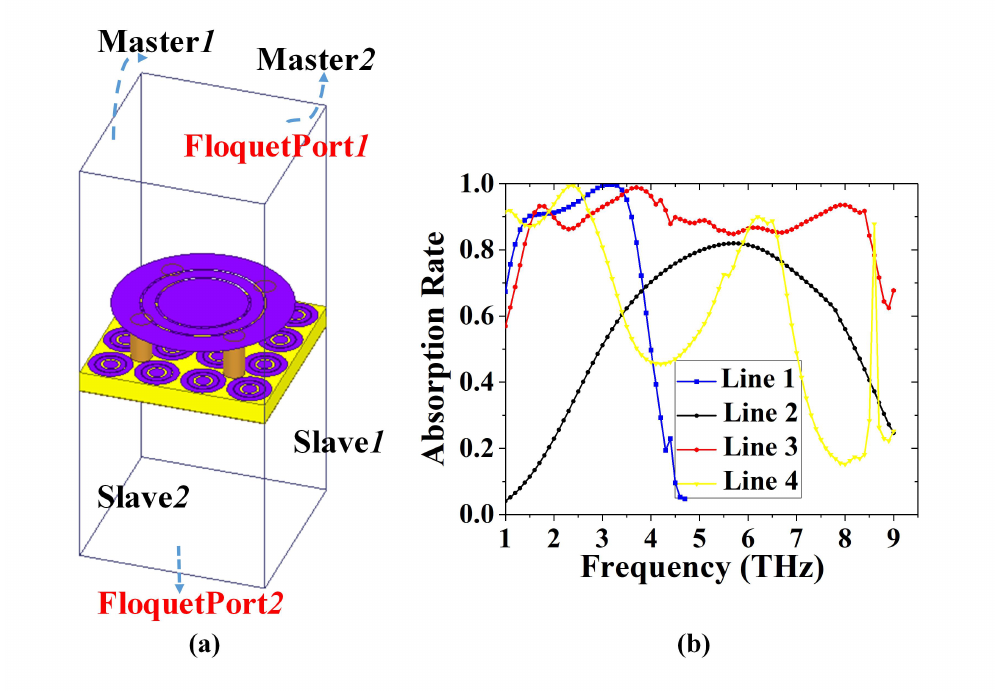
( a ) Boundary and Excitation setting for the unit cell of the proposed absorber, ( b ) The simulated frequency responses for Line 1: with the first graphene layer, Line 2: with the second graphene layer, Line 3: the proposed absorber, Line 4: without the cylinders array.